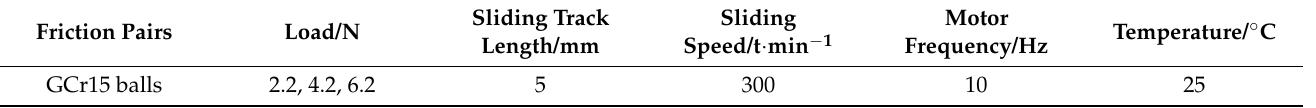
Table 2. The specific experimental parameters of friction and wear test. Sliding Track Friction Pairs Load/N Length/mm GCr15